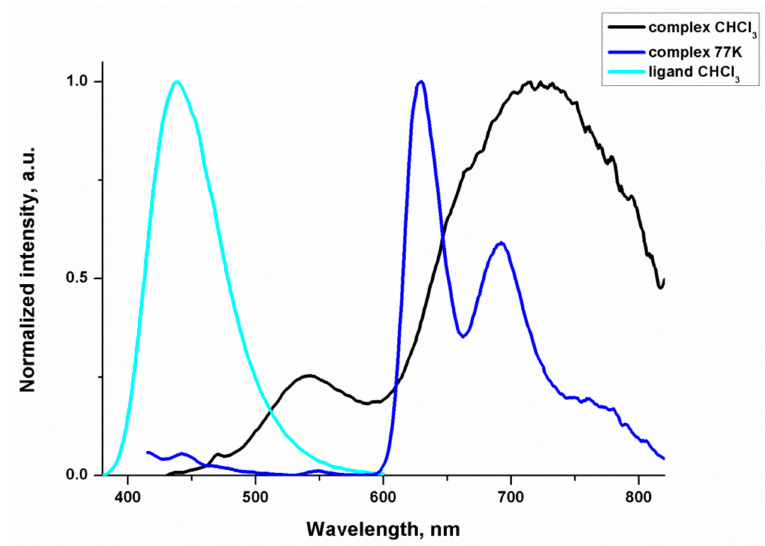
Figure 8. Emission spectra of 6 in deaerated solutions CHCl 3 (black line) (concentration 25 µ M) compared with spectra of corresponding ligand Ar 6 -dtpy in CHCl3 (blue line) and CH 3 CN (green line).